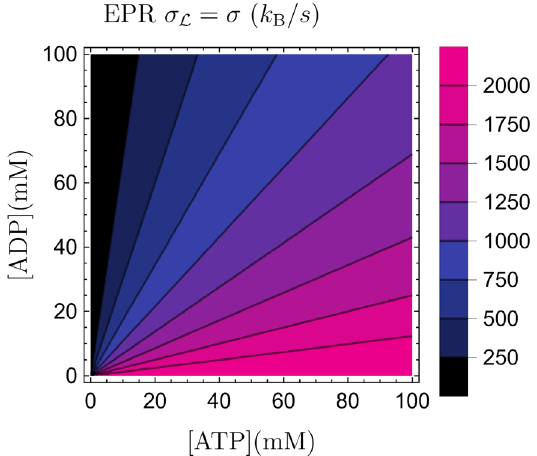
FIG. 9. Entropy production rate in k B =s for the dynein with visible transitions 6 ↔ 7 , using rates from Table I and ½ Pi (cid:2) ¼ 1 mM, in terms of ATP and ADP.